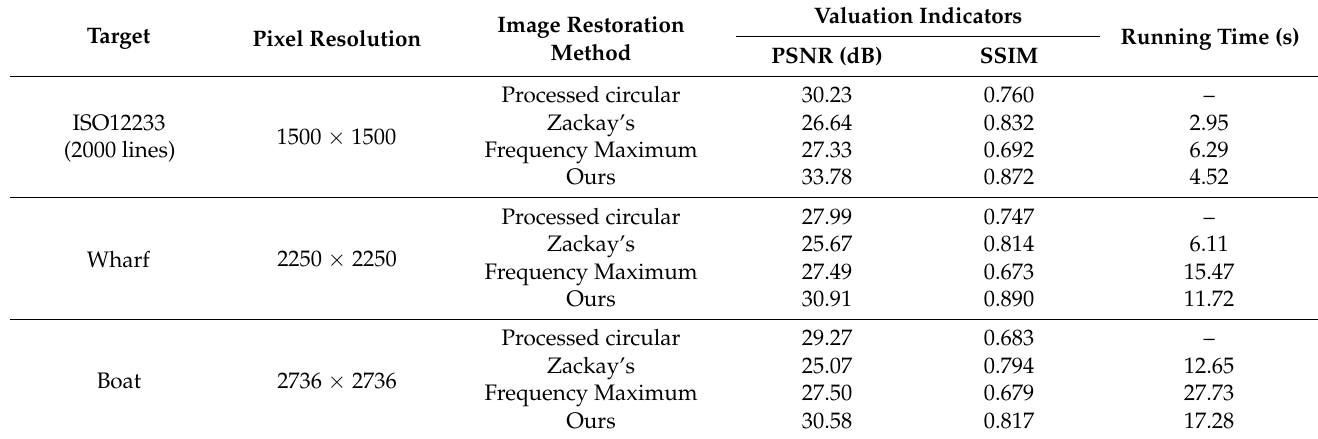
Table 2. Comparison of different methods’ evaluation indicators and time